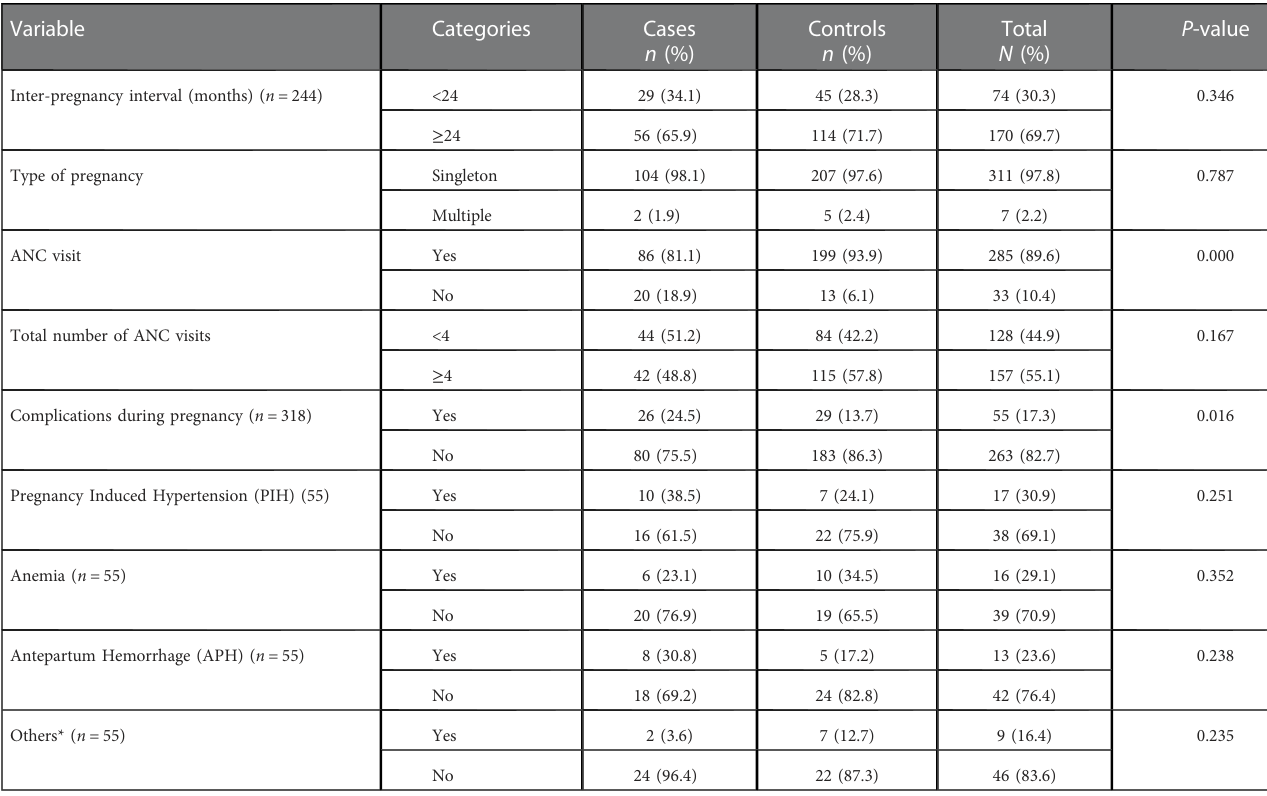
TABLE 3 Index pregnancy characteristics of study participants with and without primary postpartum hemorrhage in the public hospital of southern Tigray, Ethiopia,